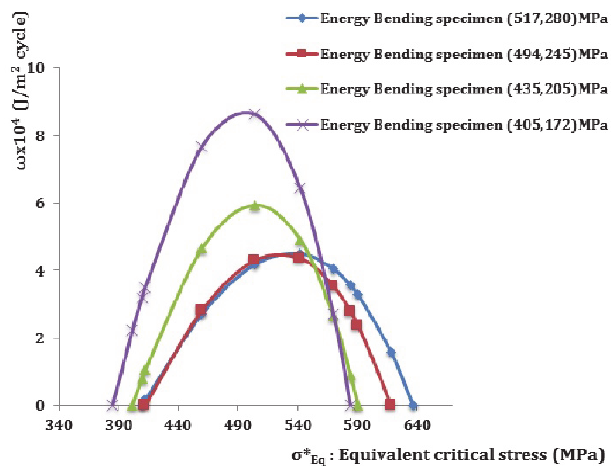
Figure 2: Over-energy (D.R.B) for various stress values of 30NCD16